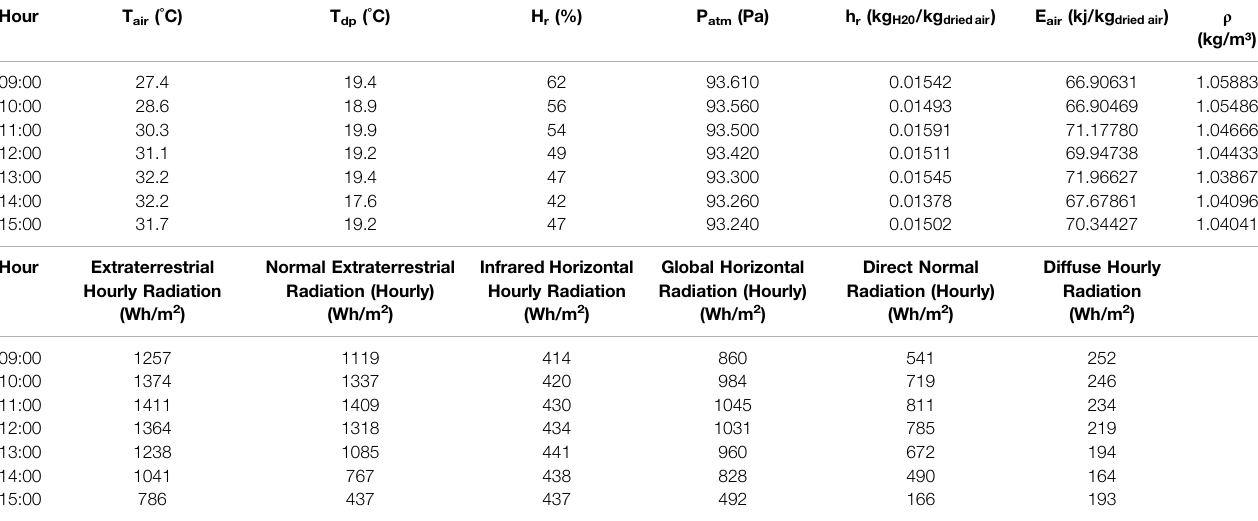
TABLE 1 | Sample of hourly weather data for a typical day in January 2015. (Source: Guimarães et al., 2014). Hour T air ( ° C)